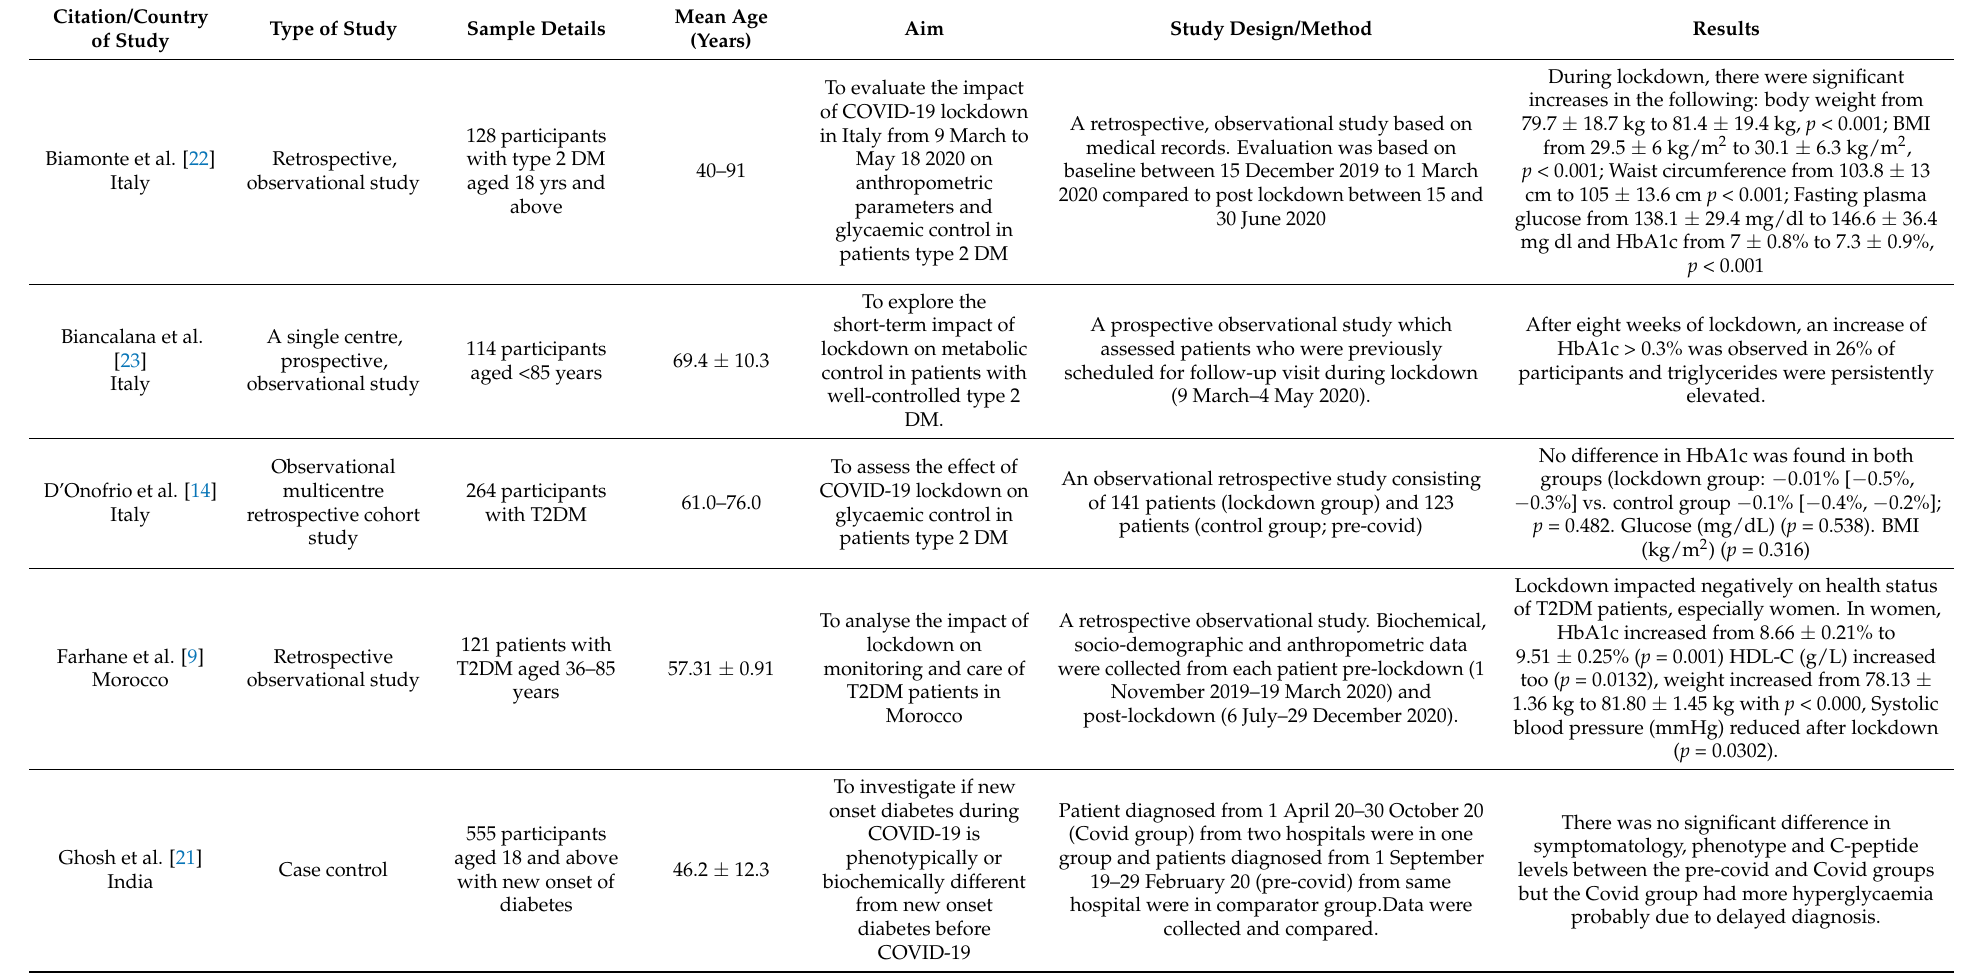
Table 2. The description and characteristics of included